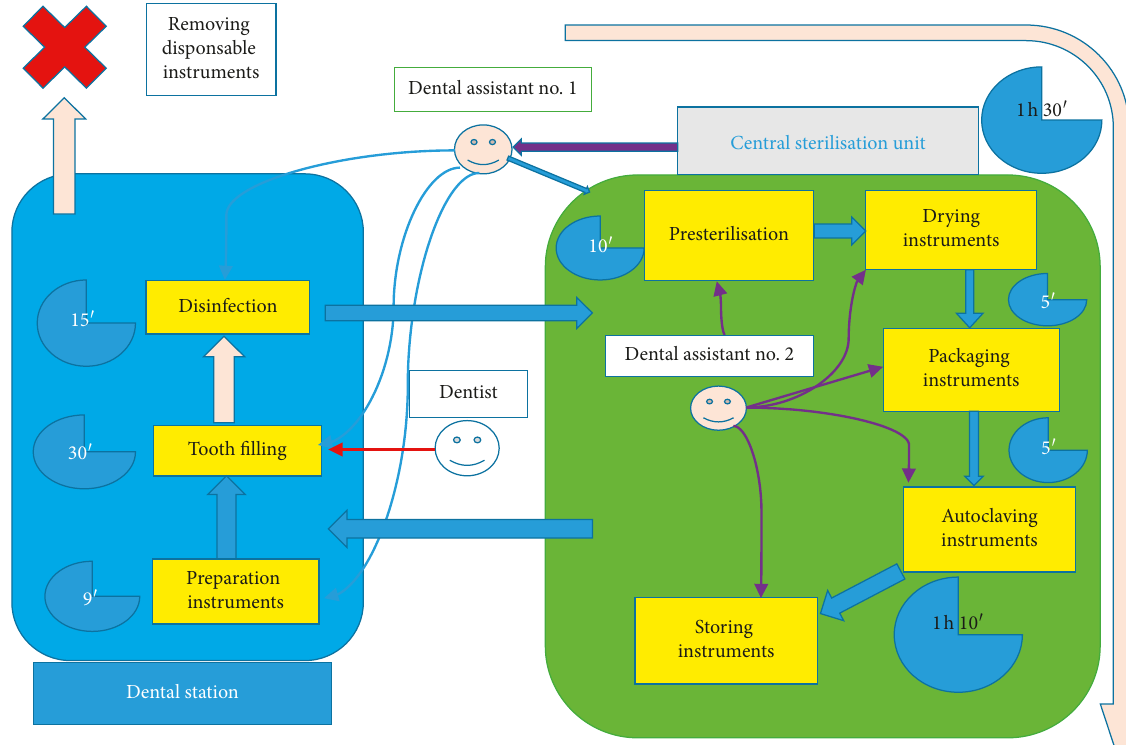
Figure 3: Sterilisation and disinfection cycle of dental instruments, with relative timings and tasks for each member of the dental team (Finding